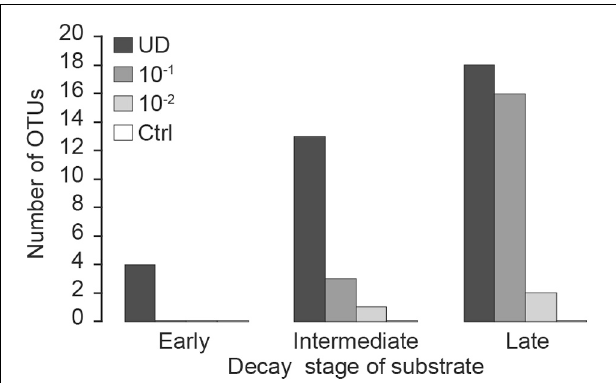
FIGURE 1 | Number of ITS1F-GC/ITS2 fungal DNA-derived DGGE bands (Operational Taxonomic Units; OTUs) in Norway spruce pooled substrate samples at the beginning of incubation under a range of inoculum dilutions (UD, undiluted fungal inoculum; dilution 10 − 1 g inoculum/g substrate (dm); dilution 10 − 2 g inoculum/g substrate (dm); Ctrl, autoclaved sawdust) for early, intermediate and late stages of